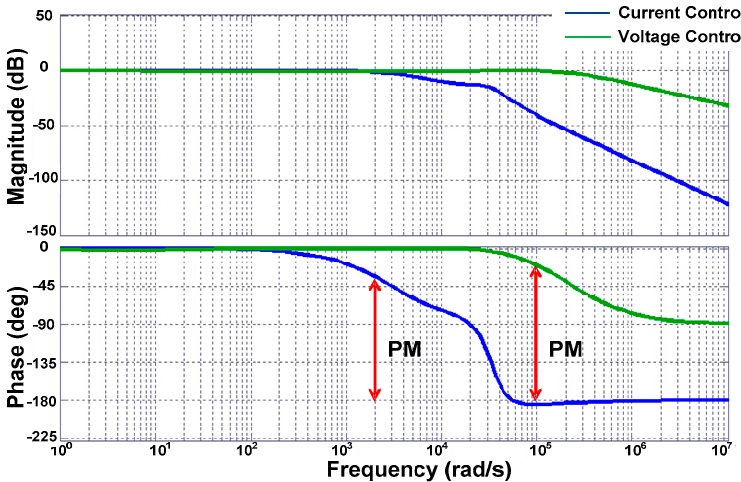
Figure 7. Bode diagram of closed ‐ loop transfer function.